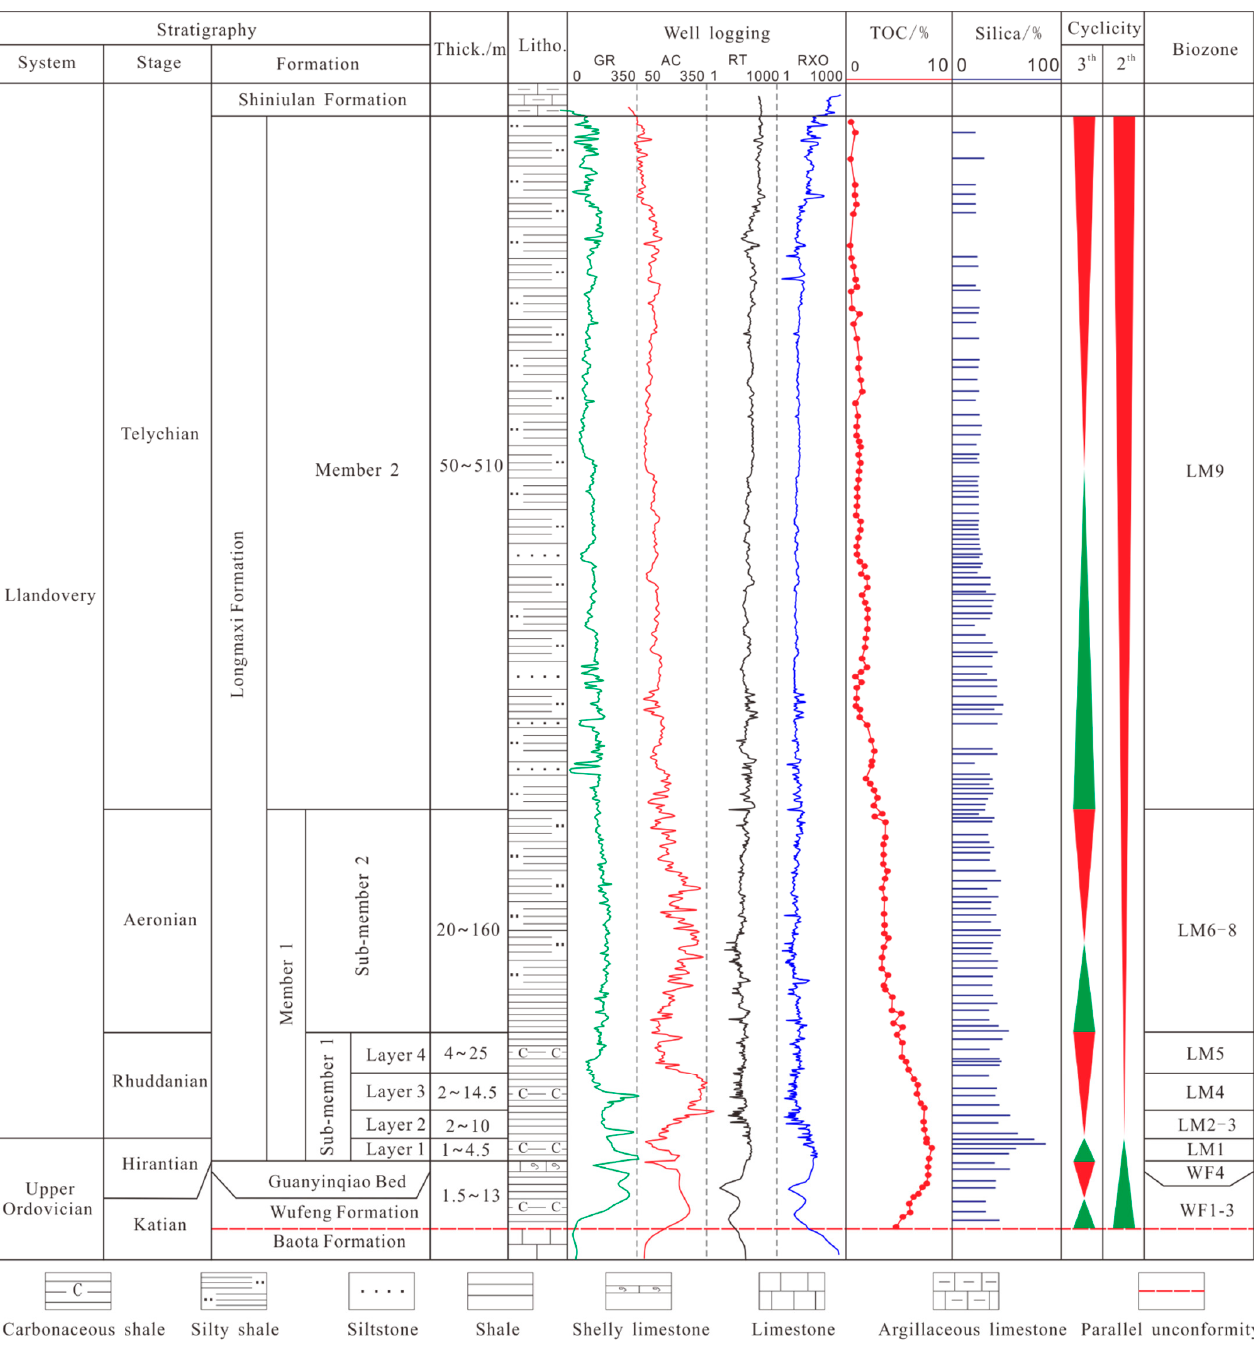
Figure 2. Stratigraphic column and study interval of the Wufeng–Longmaxi shale (modified from [24]). WF1 refers to the Dicellograptus complanatus biozone, WF2 refers to the Dicellograptus complexus biozone, WF3 refers to the Paraorthograptus pacificus biozone, and WF4 refers to the Metabolograptus extraordinarius biozone; LM1 refers to the Metabolograptus persculptus biozone, LM2 refers to the Akidograptus ascensus biozone, LM3 refers to the Parakidograptus acuminatus biozone, LM4 refers to the Cystograptus vesiculosus biozone, LM5 refers to the Coronograptuscyphus biozone, LM6 refers to Demirastrites triangulates , LM7 refers to the Lituigraptus convolutes biozone, LM8 refers to the Stimulograptus sedgwickii biozone, and LM9 refers to the Spirograptus guerichi biozone [44].